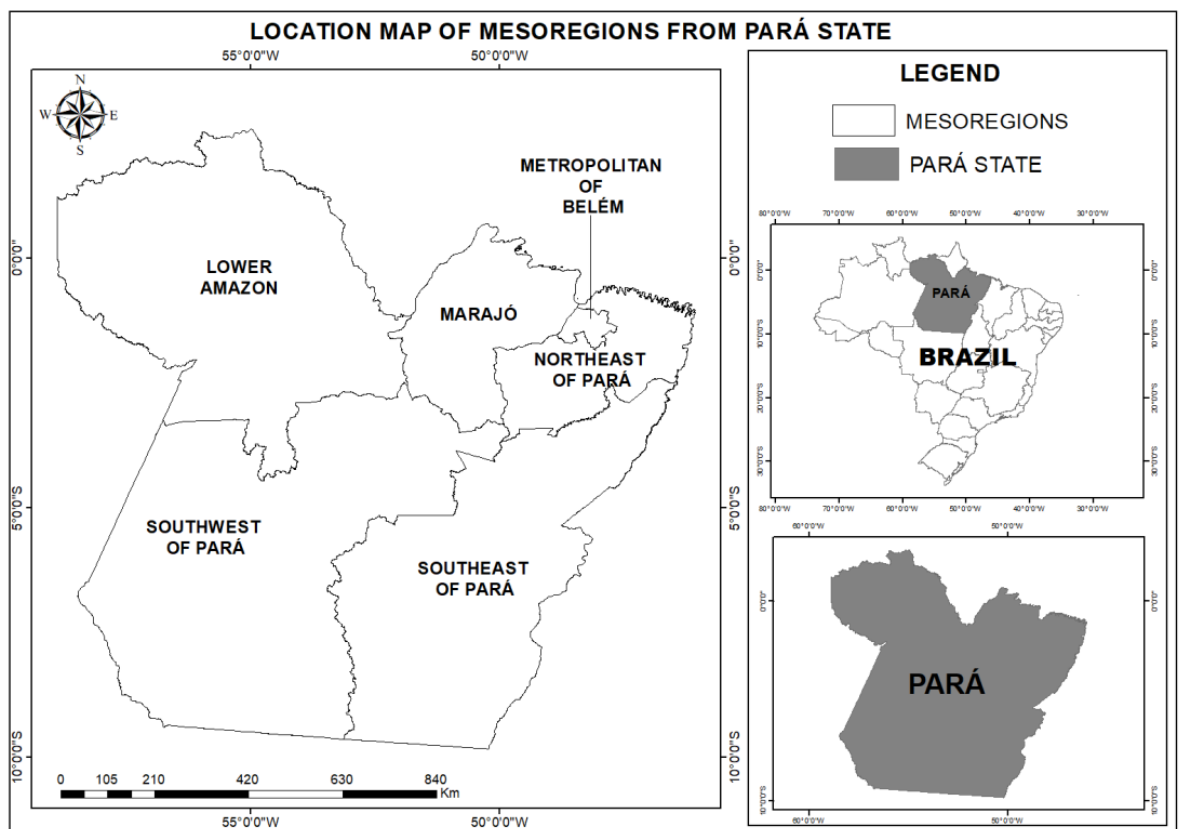
Figure 1. Mesoregions of state of Pará.